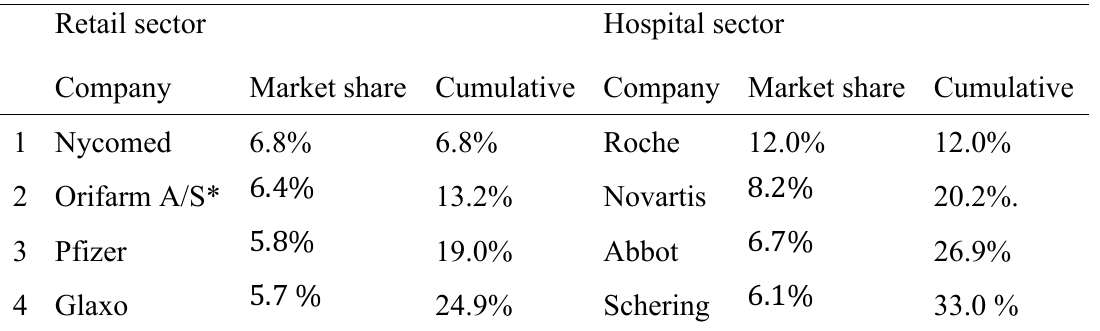
Table 1A: Market concentration of the 4 largest pharmaceutical companies in 2009 Retail sector